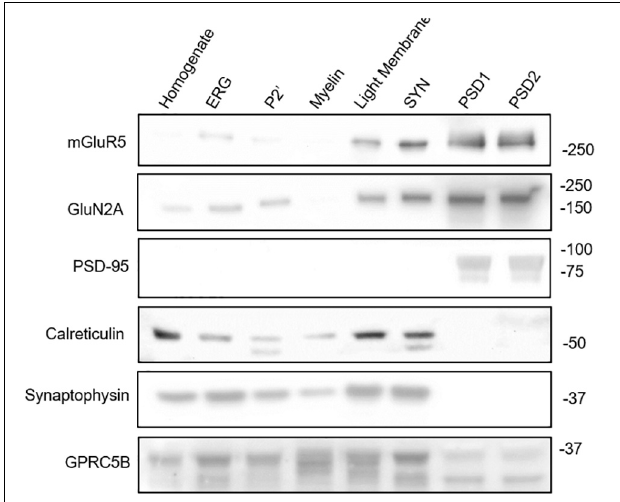
FIGURE 10 | GPRC5B subcellular localization. Biochemical brain fractionation followed by western blot analysis were conducted to investigate the subcellular localization of GPRC5B. PSD95 immunoblot was used to confirm post-synaptic density, calreticulin for ER-Golgi, and synaptophysin for pre-synaptic membranes. Western blots of the synaptic GPCR mGluR5 and of the NMDAR subunit NR2A served as a reference for subcellular distribution. Detailed explanation of distinct fractions is provided in the Section “Materials and